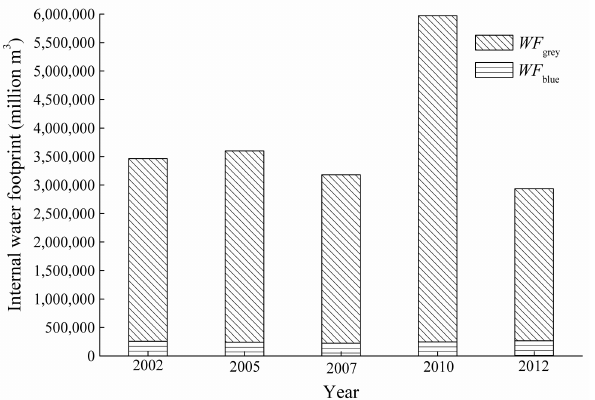
Figure 2. Internal water footprint (WF) of China from 2002 to 2012.